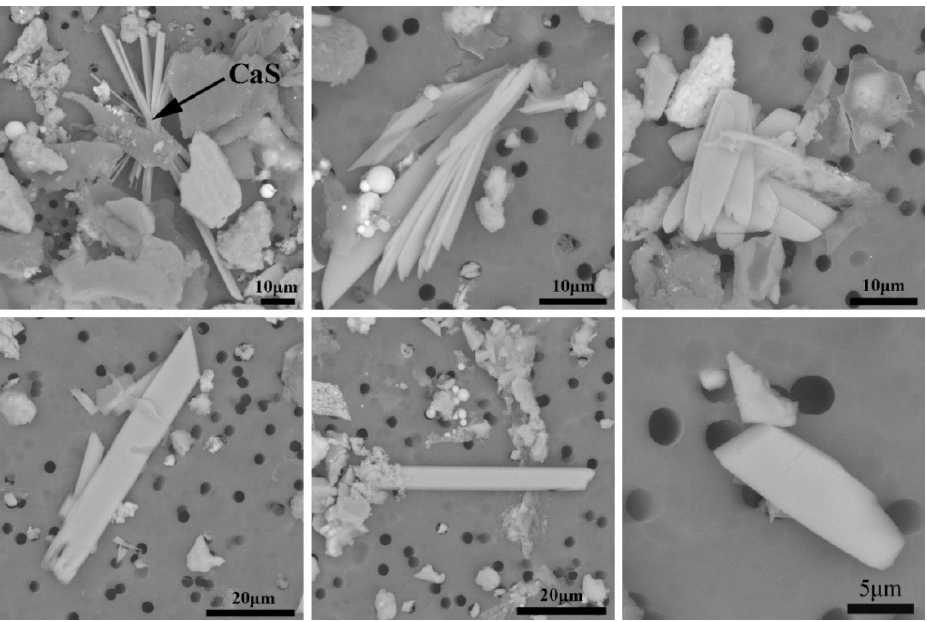
Figure 6. The characteristics following inclusions of CaS under water-cooling conditions. ( a ) The three-dimensional morphology following inclusions of CaS. ( b ) The EDS spectra and mapping of particle B.